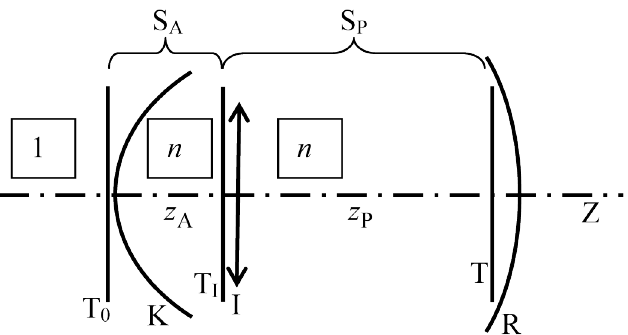
Figure 1 A simplified eye with cornea K of power F and an im- K planted thin intraocular lens I of power F . The distance between I the cornea and the intraocular lens is A z and between I and the retina R is P z . S is the anterior part and S the posterior part A P of the